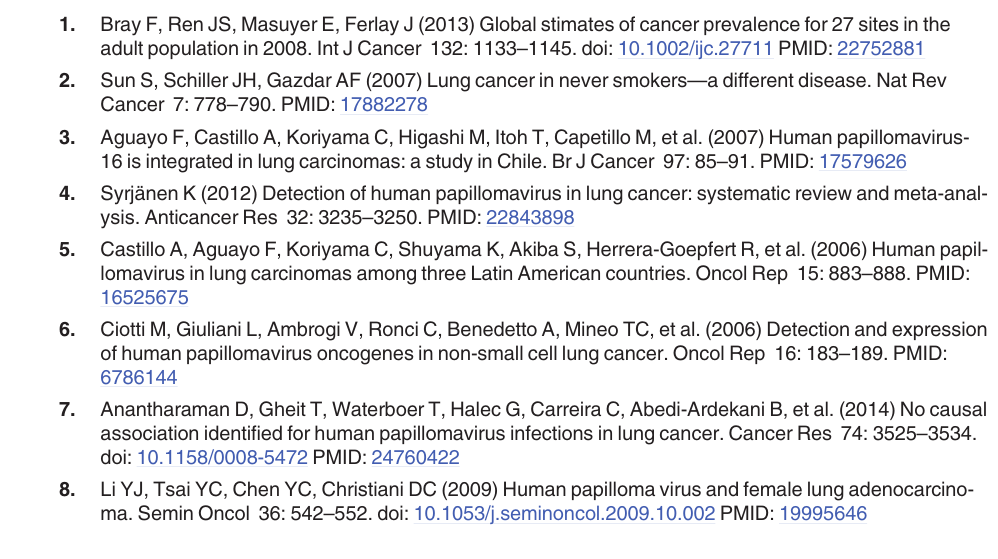
Total Area ± SEM). (TIF) S4 Fig. γ H2AX phosphorylation in lung cells exposed to CSC. BEAS-2B (A) and A-549 (B) cells were transfected with an empty vector (upper) or pLXSNE6/E7 oncogenes (below) and ex- posed to 10 μ g/mL CSC. γ H2AX phosphorylation was measured using immunofluorescence. (TIF) S5 Fig. Dual HPV-16 E6/E7 silencing in BEAS-2B cells using different short-hairpins RNAs (shRNAs). Four shRNAs were transiently transfected in BEAS-2B lung cells ectopically expressing HPV-16 E6 and E7 oncoproteins. The expression of E6 and E7 transcripts was de- termined using RT-qPCR. The data were normalized using GAPDH expression. (TIF) S6 Fig. P16 is overexpressed in BEAS-2B ectopically expressing HPV-16 E6 and E7 onco- proteins. BEAS-2B cells stably transfected with pLXSNE6E7 plasmids where pooled and p16 expression was assayed by Western blotting.